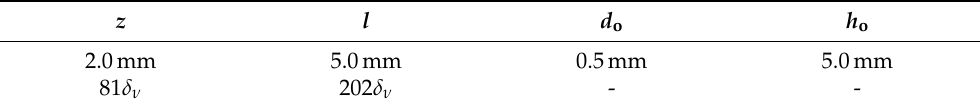
Figure 6. Orifice array: photograph and schematic (top view). Table 1. Orifice array geometry dimensions.